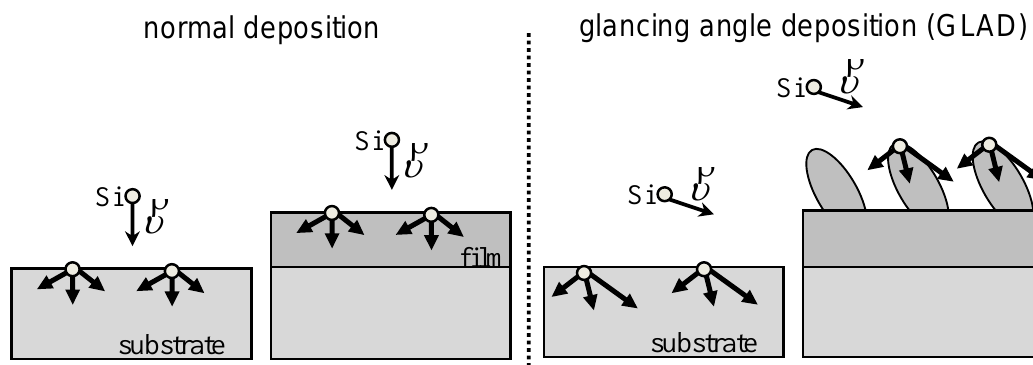
Figure 4. Explanation for the differences in the stress dependence on film thickness for normal deposition and glancing angle deposition (GLAD). See the text for the details.